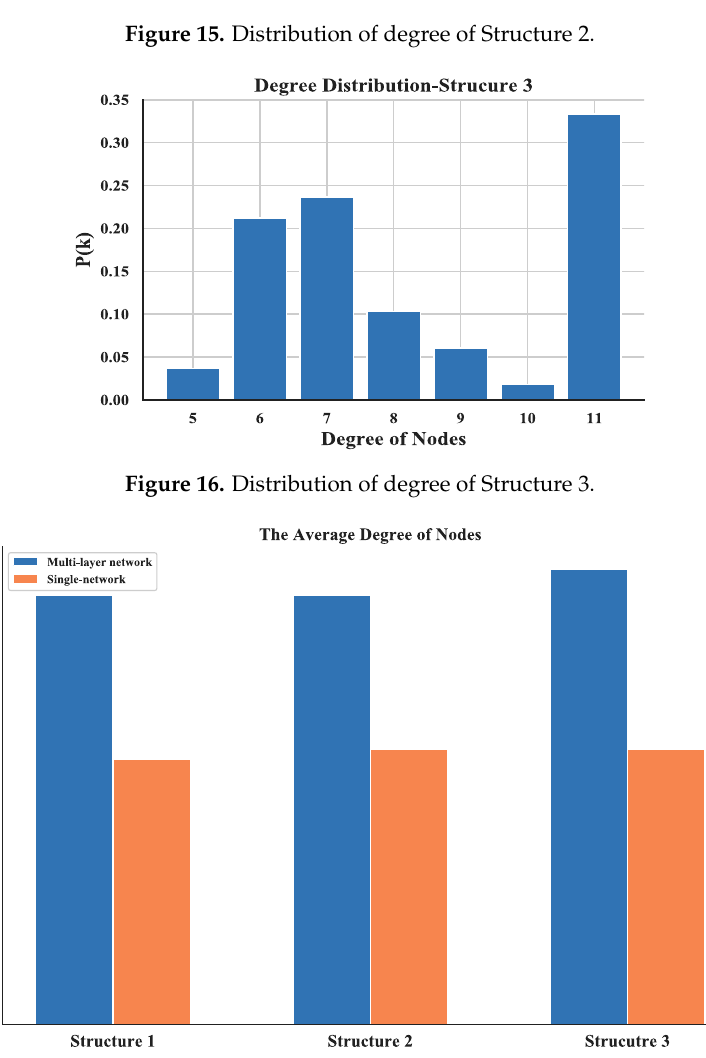
Figure 17. Comparison of average degree of nodes between multi-layer network and single network.